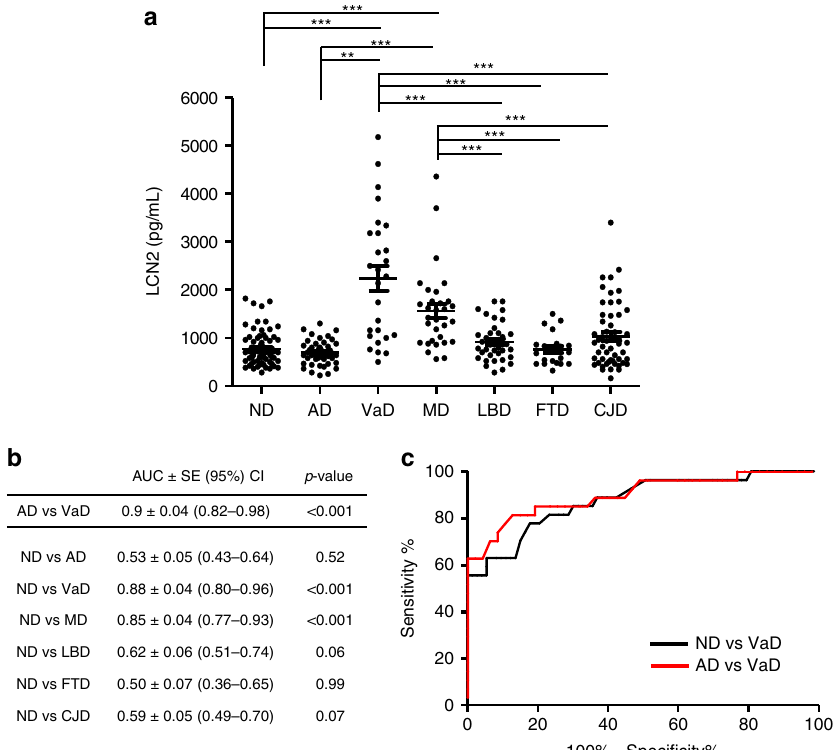
Fig. 1 CSF LCN2 in the differential diagnosis of dementia (cohort 1). a LCN2 in non-primarily neurodegenerative and non-ischemic neuropsychiatric diseases (ND, n = 73), Alzheimer ’ s disease (AD, n = 47), vascular dementia (VaD, n = 27), mixed Alzheimer ’ s and vascular dementia (MD, n = 31), Lewy body dementias (LBD, n = 36), frontotemporal dementia (FTD, n = 21), and sporadic Creutzfeldt-Jakob disease (CJD, n = 54). Results are shown as mean ± SD for each condition. b Area under the curve (AUC) derived from receiver operating characteristic (ROC) curves, Standard Error (SE), 95% Con fi dence interval (95% CI) for LCN2 in the comparative analyses. c ROC curves of differentiating ND and VaD as well as AD and VaD. Differences between groups were analysed with Tukey contrasts using linear regression models controlled for age and sex. * p < 0.05, ** p < 0.01, *** p <